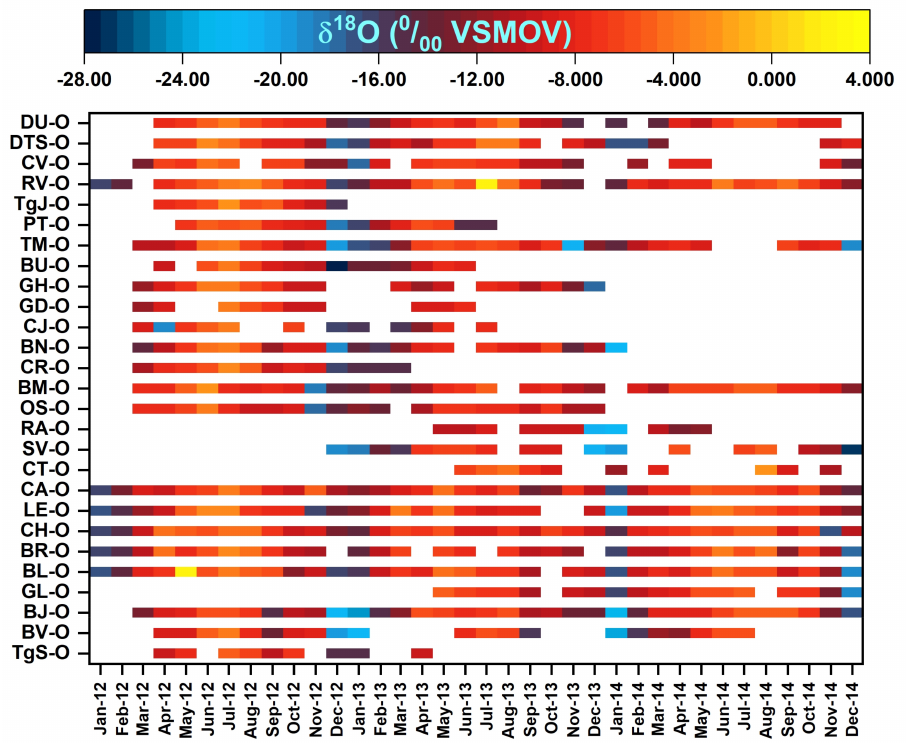
Figure 3. The temporal variation of stable δ 18 O at the analyzed stations for the January 2012 to December 2014